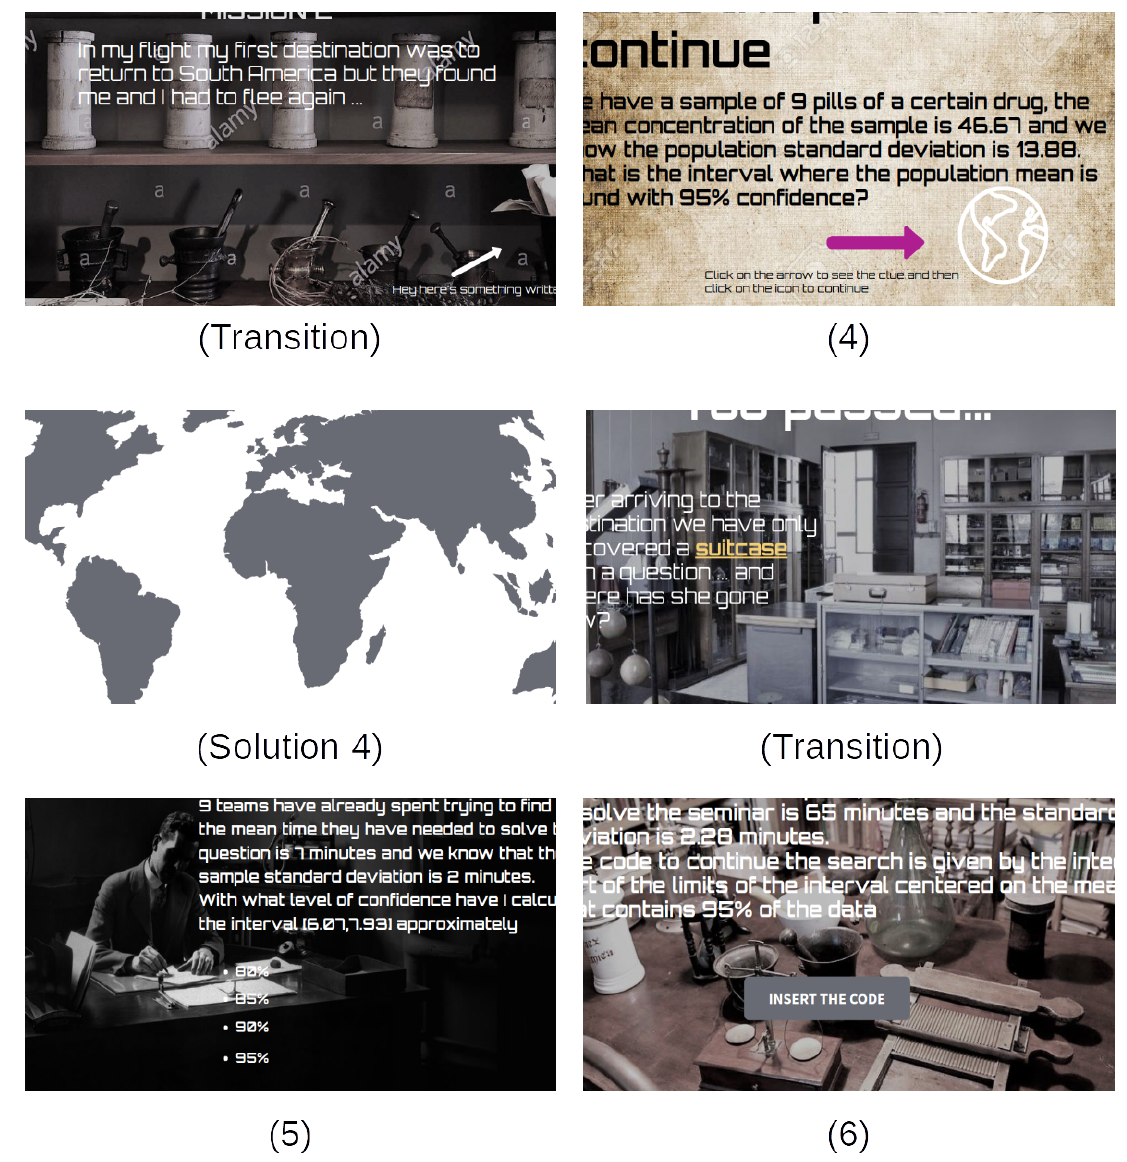
Figure A4. Screens of mission